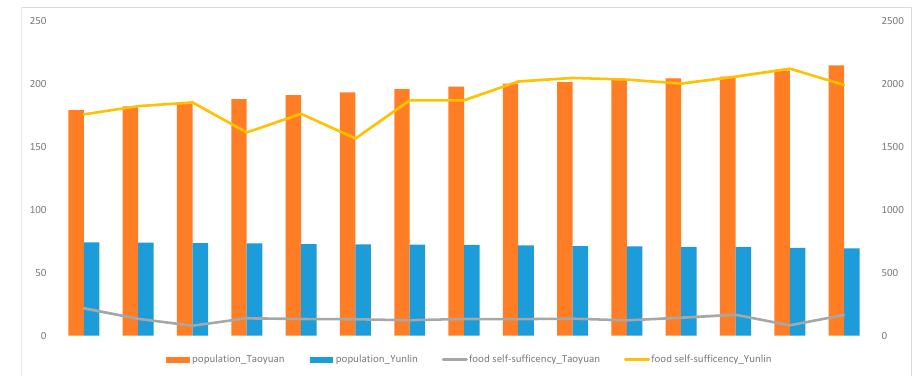
Figure 2. Food self-sufficiency (%, left scale) and population (thousand people, right scale) in Taoyuan and Yunlin, 2002–2014.